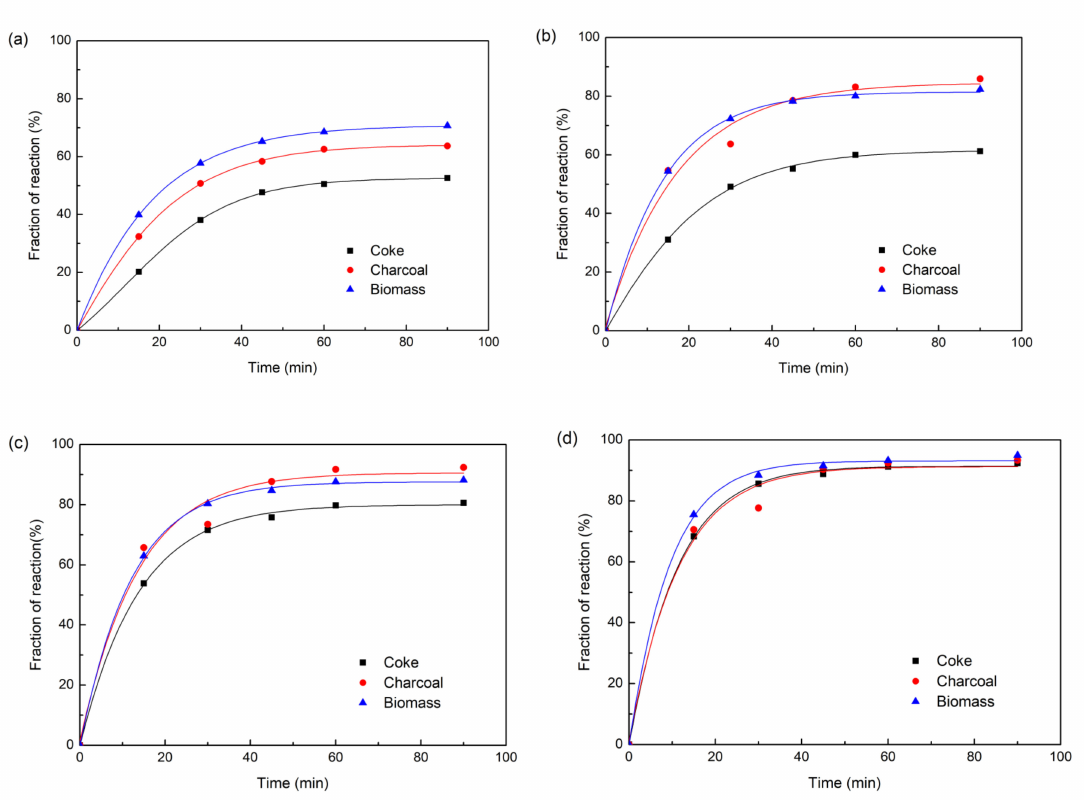
Figure 3. The fraction of reaction of the three composite pellets with different reducing agents: ( a ) 900 ◦ C, ( b ) 1000 ◦ C,